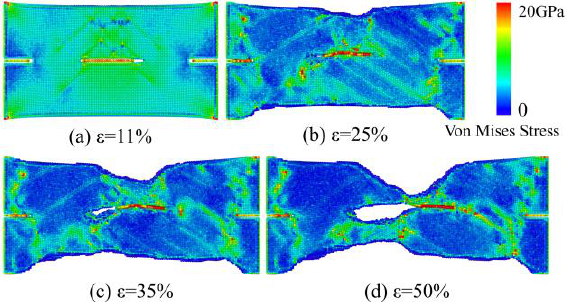
Figure 16. Stress distribution of Gr/Cu-1 under different strains. ( a ) ε = 11%, ( b ) ε = 25%, ( c ) ε = 35% and ( d ) ε = 50%.